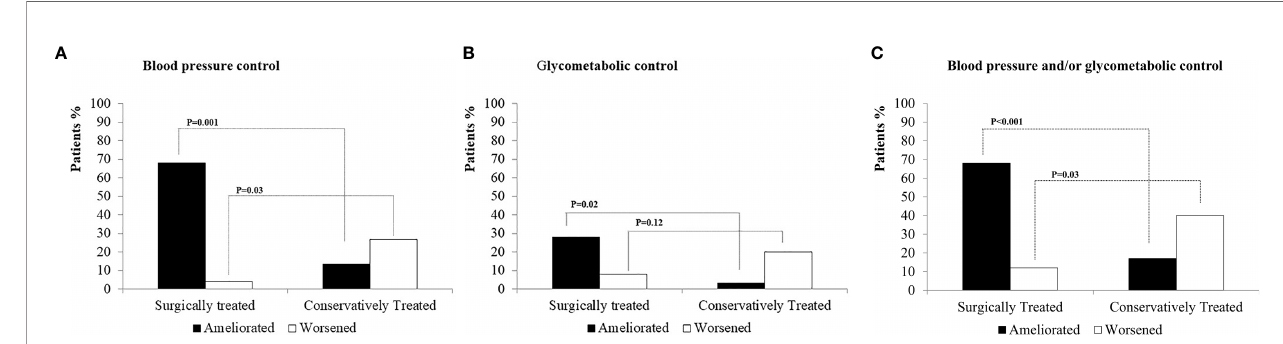
FIGURE 2 | Amelioration and worsening of blood pressure and/or glycometabolic control in surgically treated or conservatively managed AI patients with PACS. AI, adrenal incidentaloma; PACS, possible autonomous cortisol secretion; PACS+, patients with possible autonomous cortisol secretion; PACS-, patients without possible autonomous cortisol secretion. (A) Amelioration and worsening of blood pressure control. (B) Amelioration and worsening of glycometabolic control. (C) Amelioration and worsening of blood pressure and/or